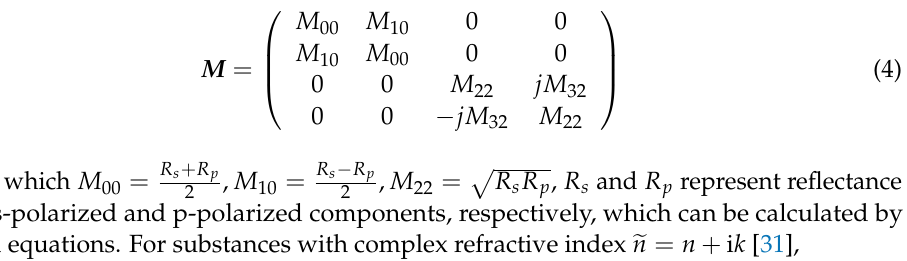
Figure 2. Geometry relation of micro-surface model. The specular reflection Mueller matrix can be solved by its corre- spondence with the Jones matrix [ Error! Reference source not found. ].